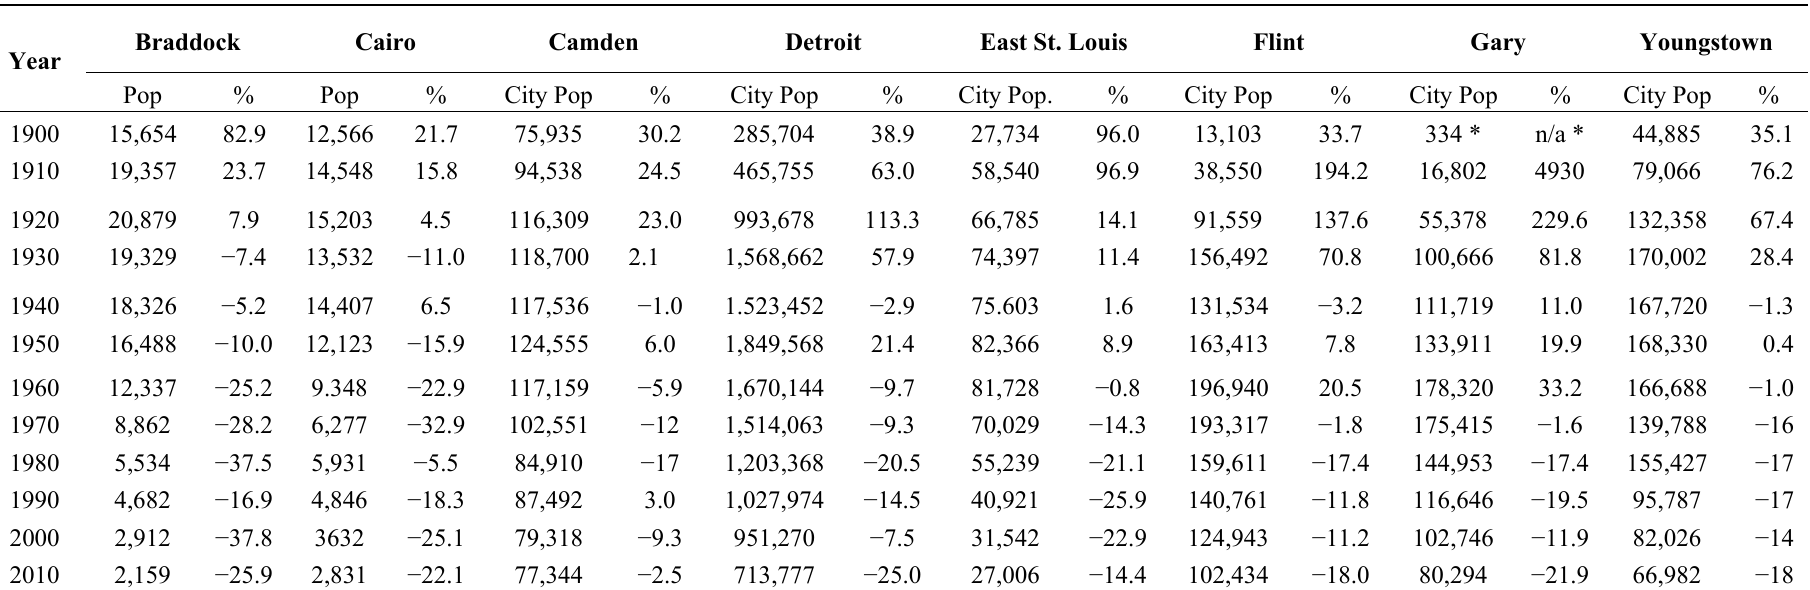
Table 1. Census data for fourth world cities: